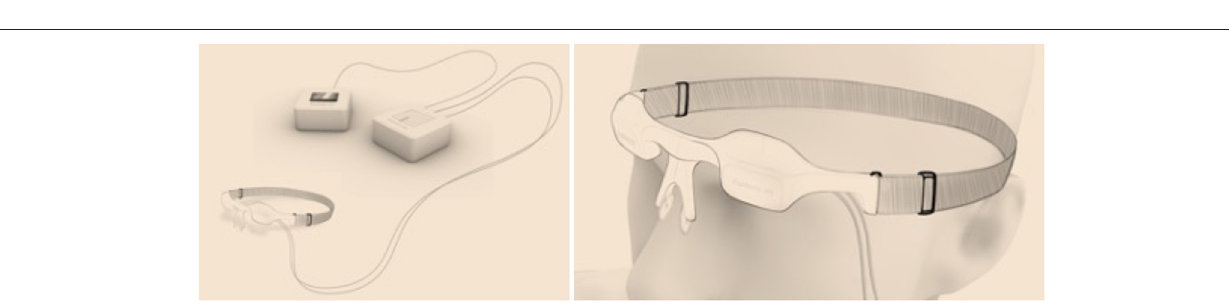
FIGURE 6 | The design sketch of the Euphotic intermittent photic stimulation device (patents pending) using a unique diffuse light concept both in eyes-open and eyes-closed conditions. Note that the Euphotic IPS device allows unique option for simultaneous visual stimulation in eyes-open